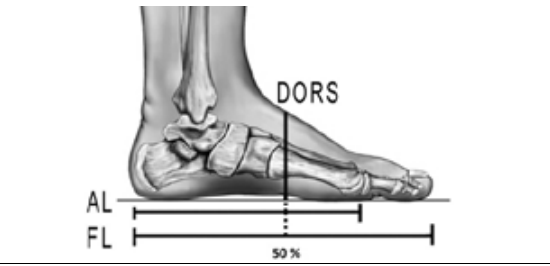
Figure 5. The Arch Index by D. S. Williams The sagittal plane of foot placed in a weight- bearing position was filmed with a digital video camcorder Canon XM-1. Before filming four markers were attached to the skin in the following landmarks on the legs of each subject: 1) head of the first metatarsal, 2) dorsum midpoint between the most posterior portion of the calcaneus to the end of the longest toe, 3) most posterior portion of the calcaneus, 4) the end of the longest toe.